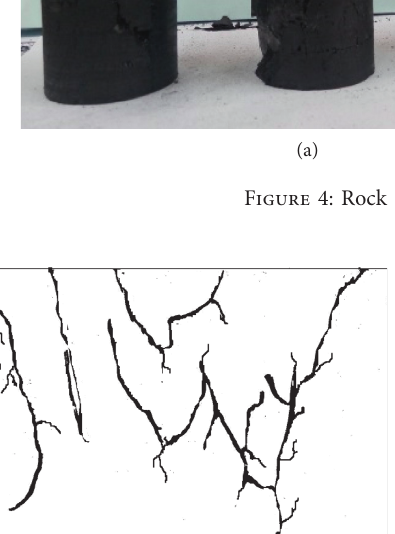
Figure 5: Distribution of surface cracks in the failed rock sample.